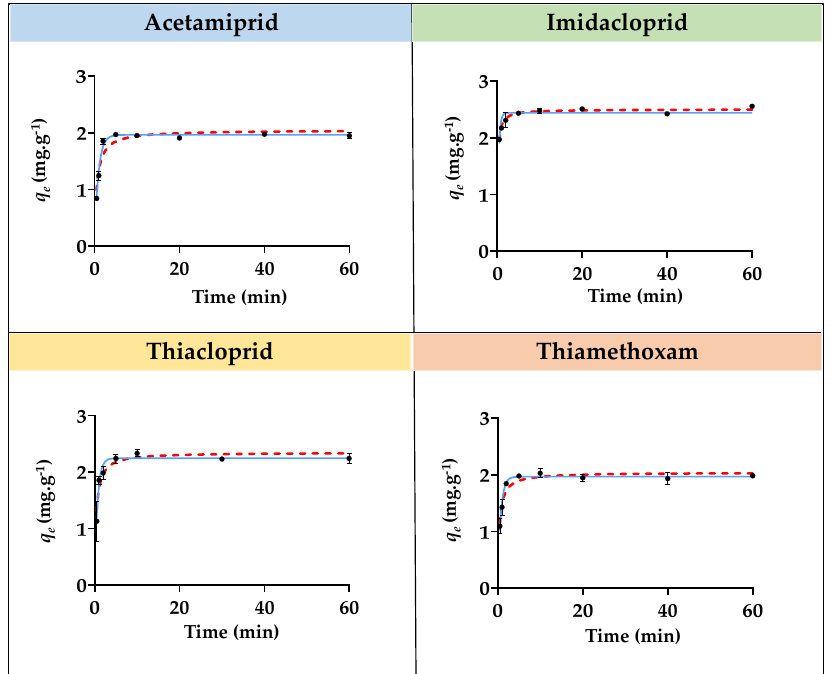
Figure 3. Adsorption kinetics curves for acetamiprid, imidacloprid, thiacloprid, and thiamethoxam insecticides with [Si][N 3888 ]Cl. The black dots correspond to the experimental data, the continuous blue line corresponds to the fitting of the experimental data with the Pseudo first ‐ order model, and the red dashed line corresponds to the fitting with the Pseudo second ‐ order model.